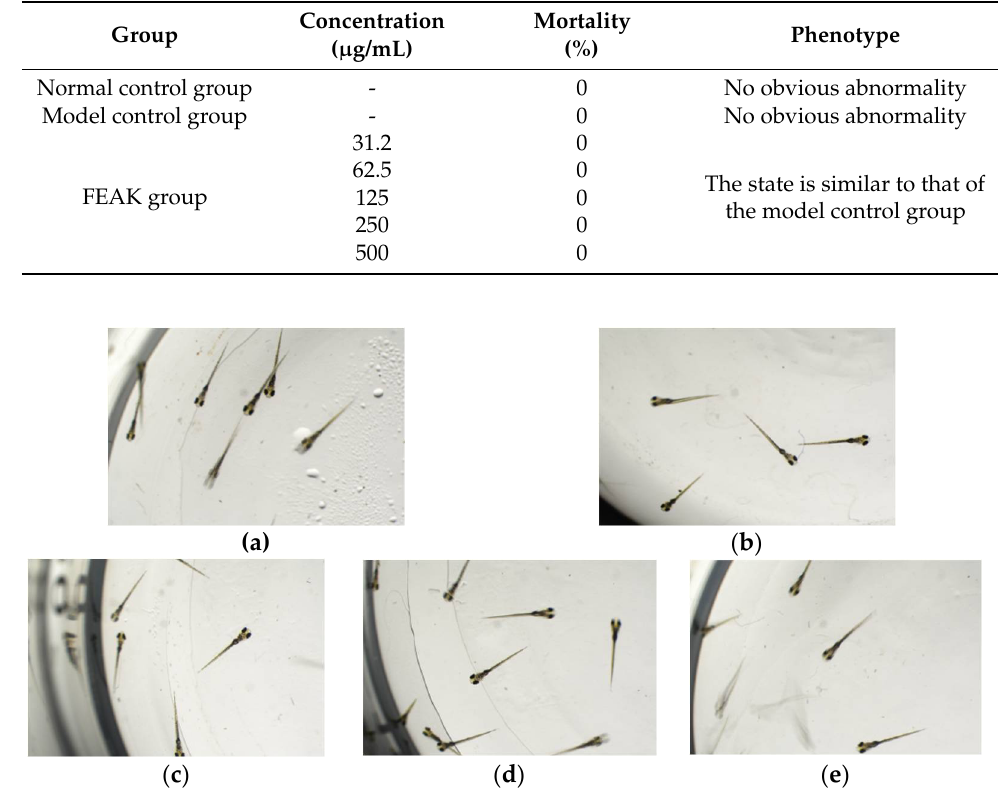
Table 3. Evaluation of MTC ( n = 30).